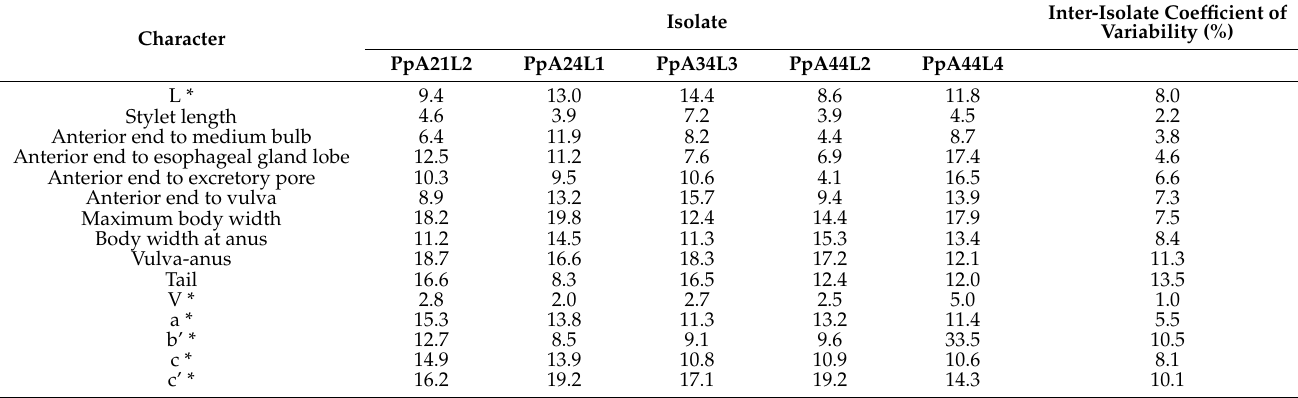
Table 3. Intra- and inter-isolate coefficient of variability (%) of Pratylenchus penetrans females from Portugal. Character